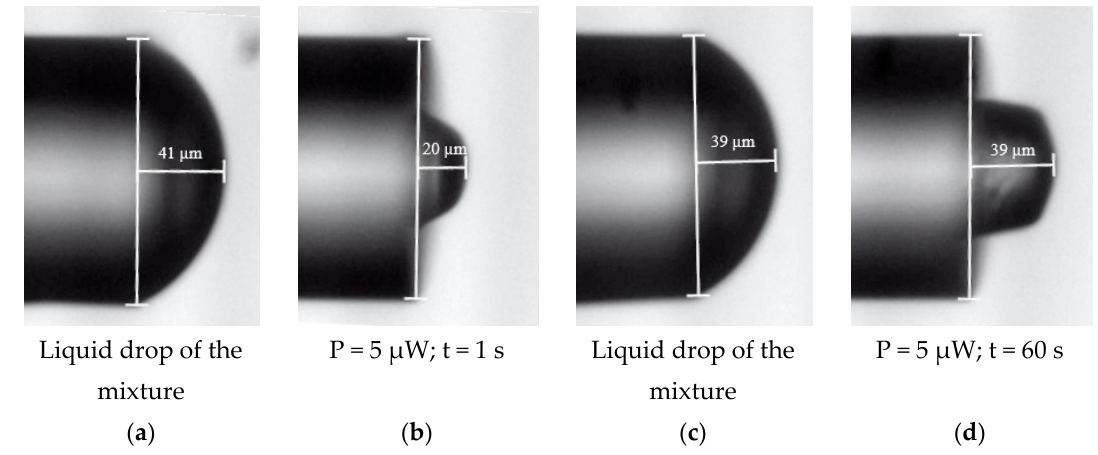
Figure 5. Optical microscope images of the gradient-index MMF with applied PETA monomer mixture drops: ( a , c ) as well as microtips formed by VIS LED with Eosin Y/amine PIS for different exposure times and the same source optical power ( b , d ).